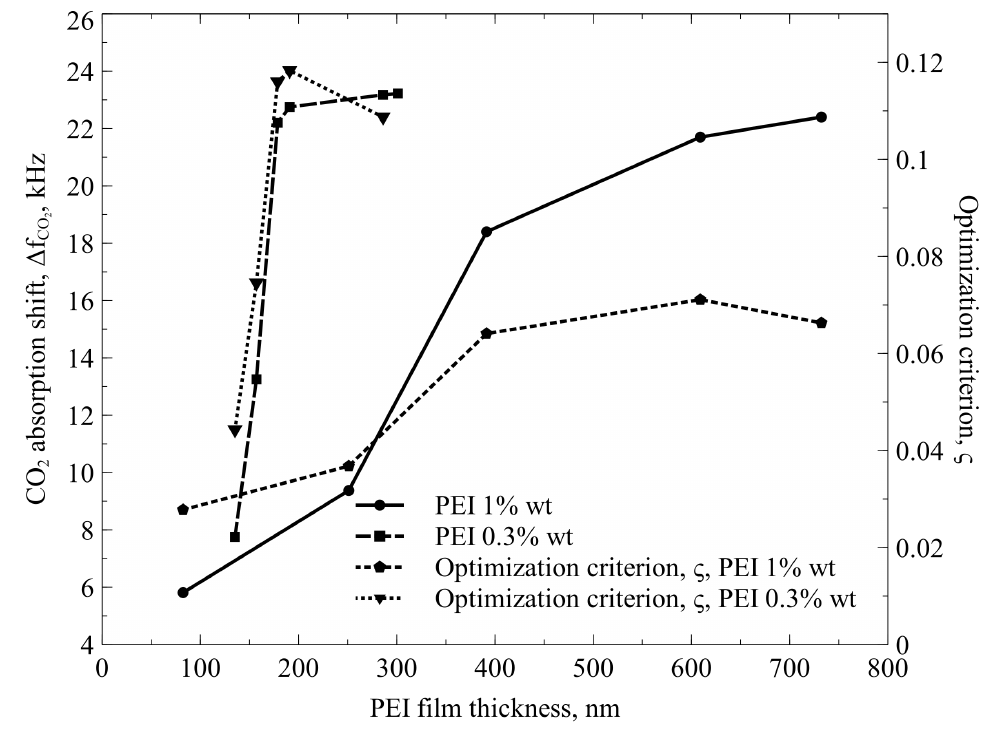
Figure 9. CO 2 absorption shift and optimization criterion as functions of the average thickness of inkjet-printed PEI film. Different PEI solutions of 1.0% and 0.3% w / v in methanol, used for printing, are additional parameters.